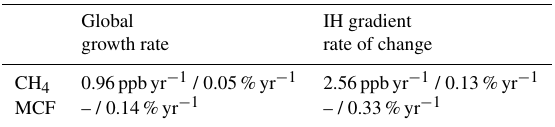
Table 2. Mean observational errors as derived from TM5 simu- lations over the 1994–2015 period. The errors were quantified as the mean difference between annual means derived from model- sampled observations and annual means derived from the full tro- pospheric grid. CH 4 uncertainties are given both in ppbyr − 1 and relative to the global mean mixing ratio. Uncertainties for MCF are only given relative to the global mean because of its strong temporal